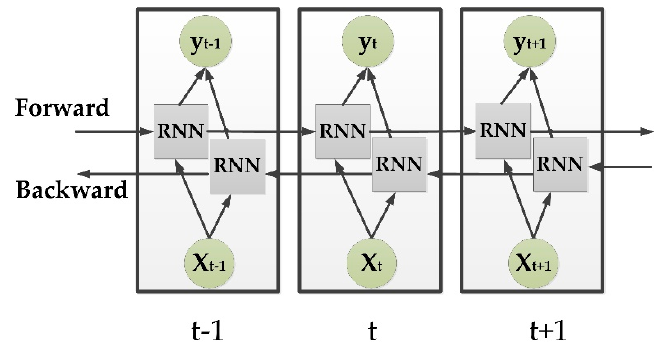
Figure 3. Bidirectional RNN expands in time.